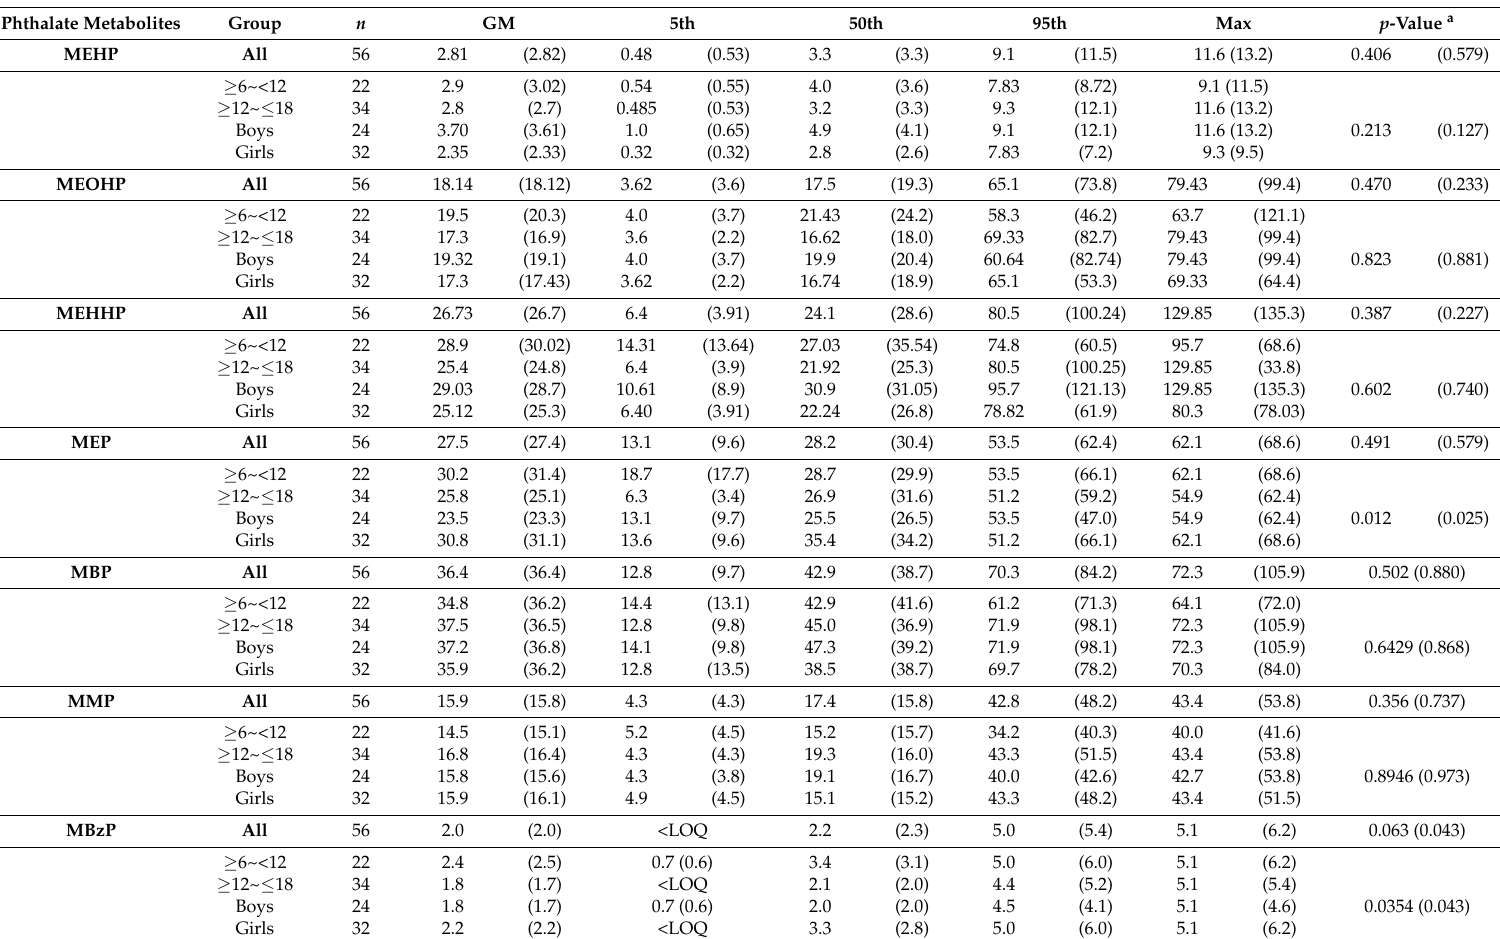
Table 3. Urinary concentrations of phthalate metabolites (in µ g/L ( µ g/g creatinine)) in Iranian children and adolescents population ( n =